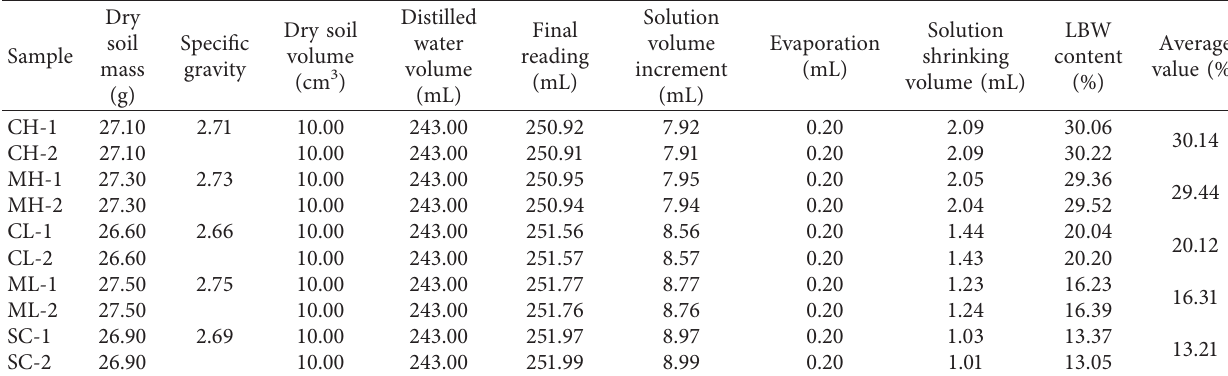
Table 3: Parallel LBW content tests on different soil